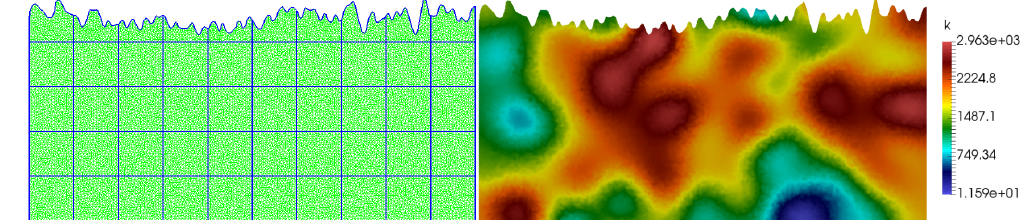
Figure 5. Computational grids and heterogeneous properties for Tests 2.DBC, 2.NBC, 2.RBC (two-dimensional problem). Left : Coarse grid (blue color) and fine grid (green color). Right : Heterogeneous coefficient k s ( x )